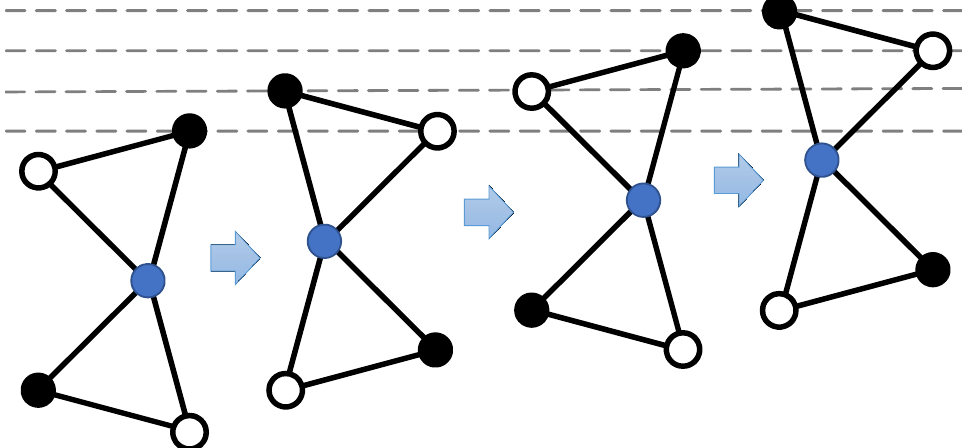
Figure 1. The kinematic model used in previous studies [31–35]. If the support legs (depicted by black circles) are completely fixed, then the waist (depicted by blue circles) can only exist at an equal point from each of the support legs, and is therefore constrained to one of the two distant points. Thus, when the angle of the waist is moved continuously, the positions of the support legs also change continuously (i.e., they